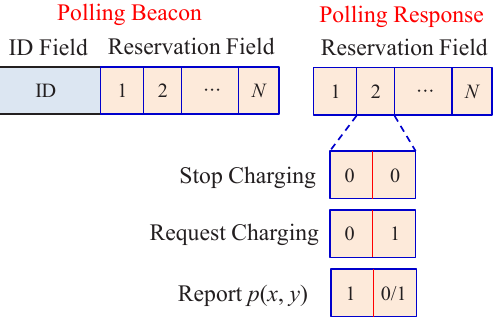
Figure 3. Message formats of polling beacon and response.